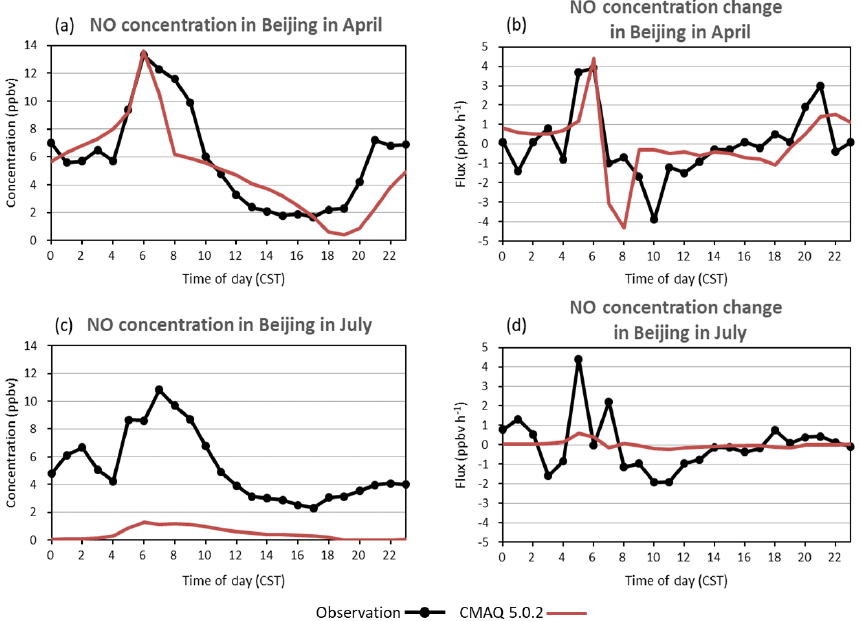
Figure 8. Monthly averaged diurnal variation in (a) NO concentration in April, (b) hourly NO concentration change in April, (c) NO concentration in July, and (d) hourly NO concentration change in July in